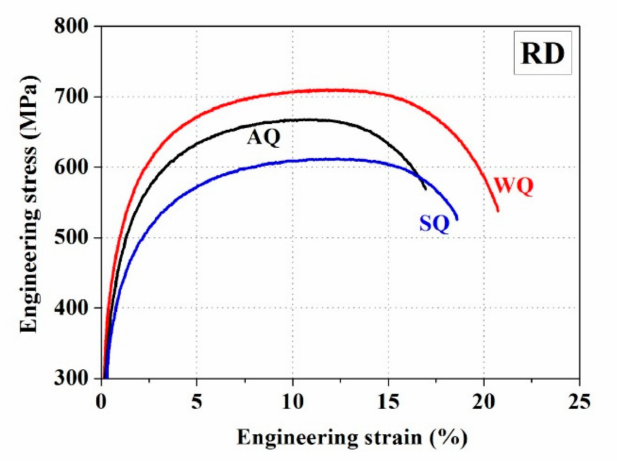
Figure 2. Engineering stress–strain curve for the investigated DP steels measured along